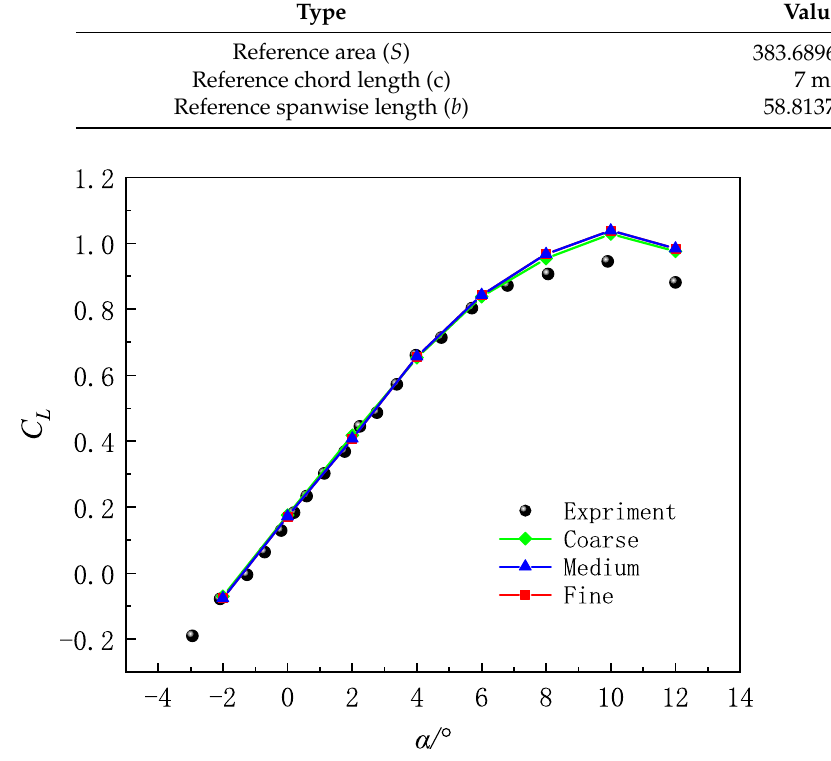
Figure 3. verification of different number of